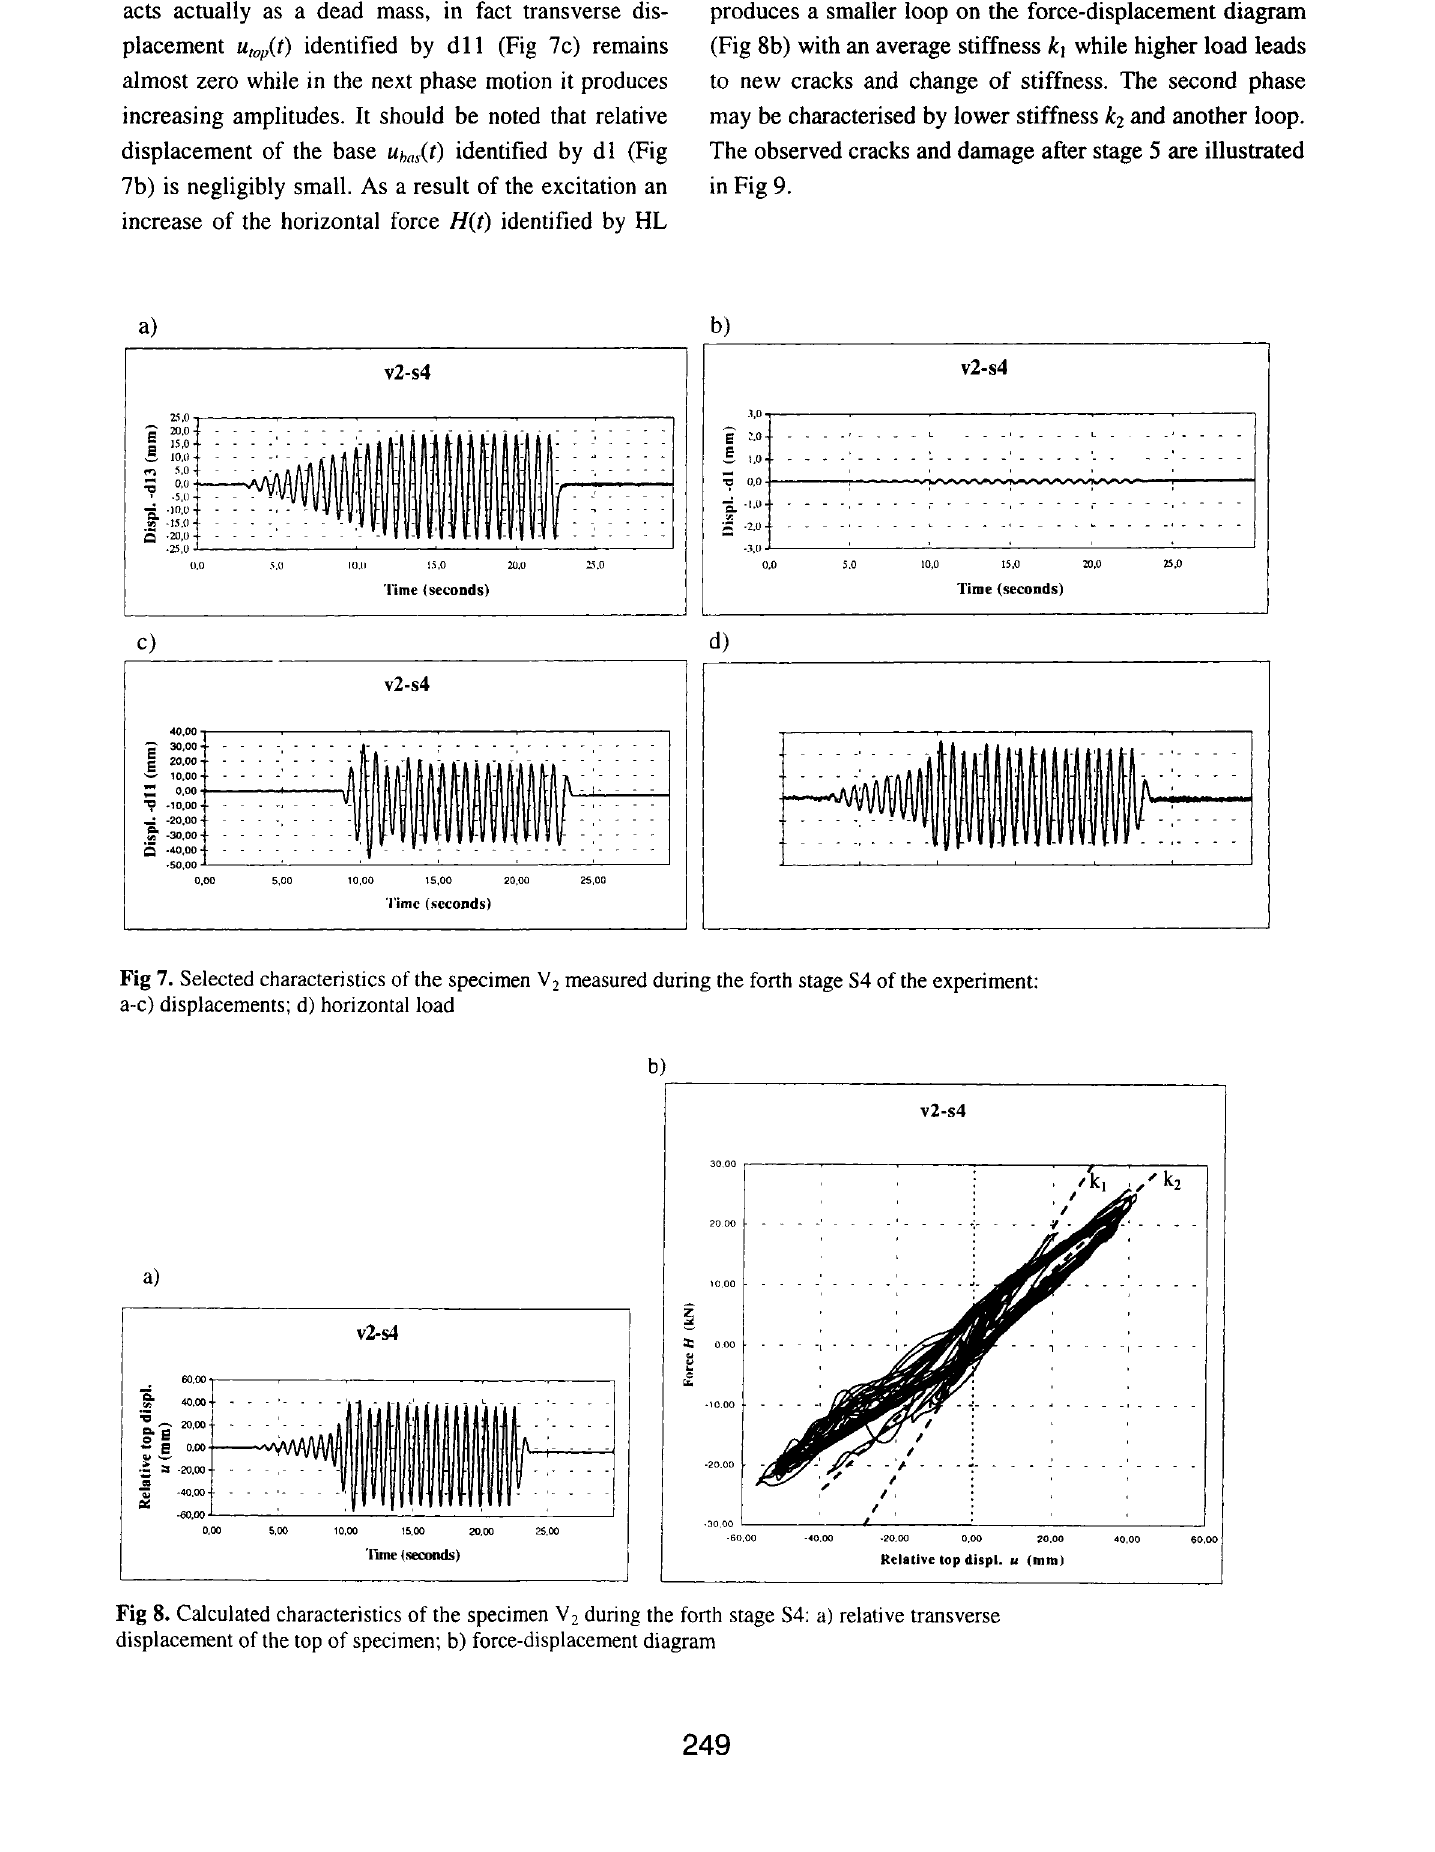
Fig 8. Calculated characteristics of the specimen Y 2 during the forth stage S4: a) relative transverse displacement of the top of specimen; b) force-displacement